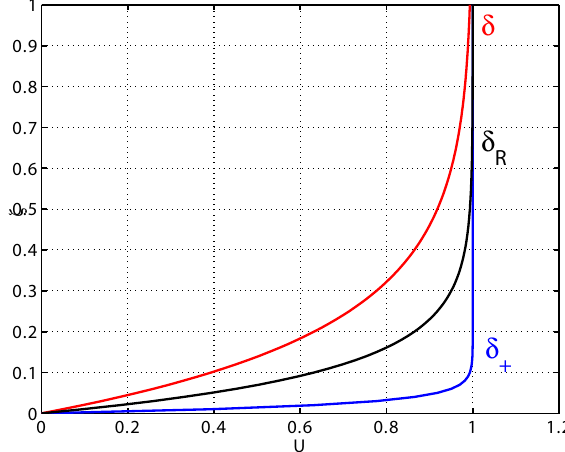
Fig. 3. Schematic of the rotational boundary layers showing the ro- tational boundary layers: blue cyclonic, red anticyclonic and black the resultant planetary boundary